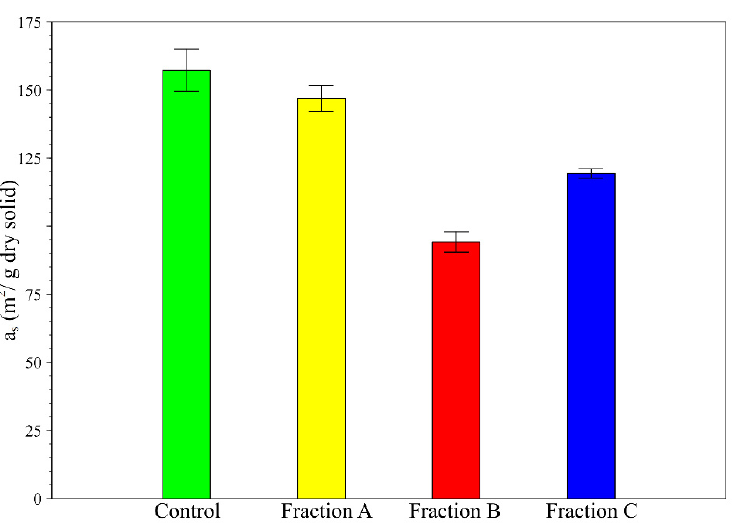
Figure 7. Specific area of Van Soest fraction ( a s ). Number of repetitions = 2.